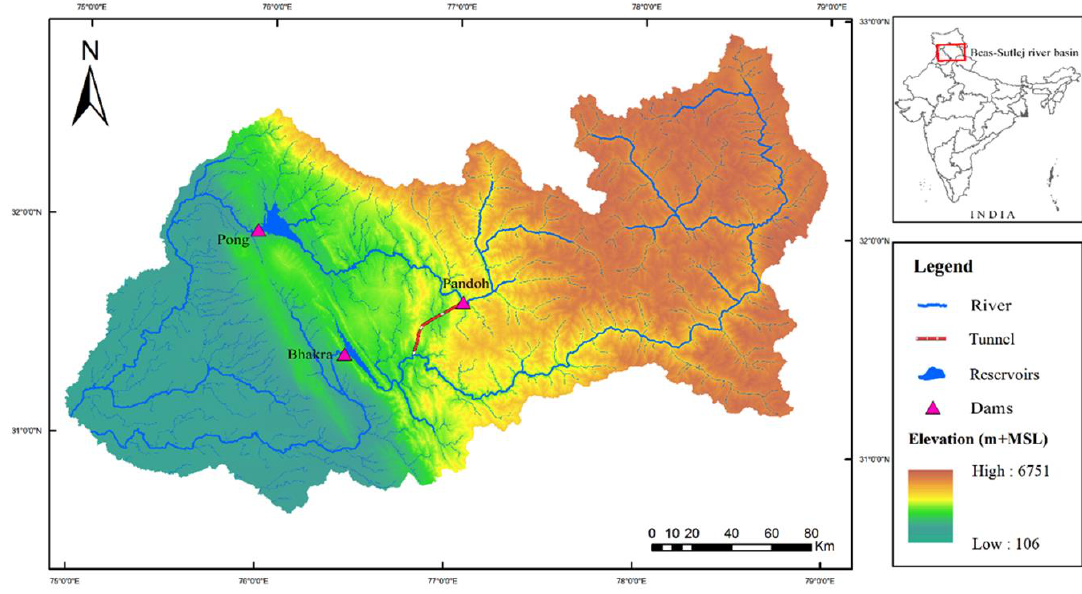
Figure 2. Locations of the main Pong and Bhakra reservoirs and the Pandoh dam diversion.